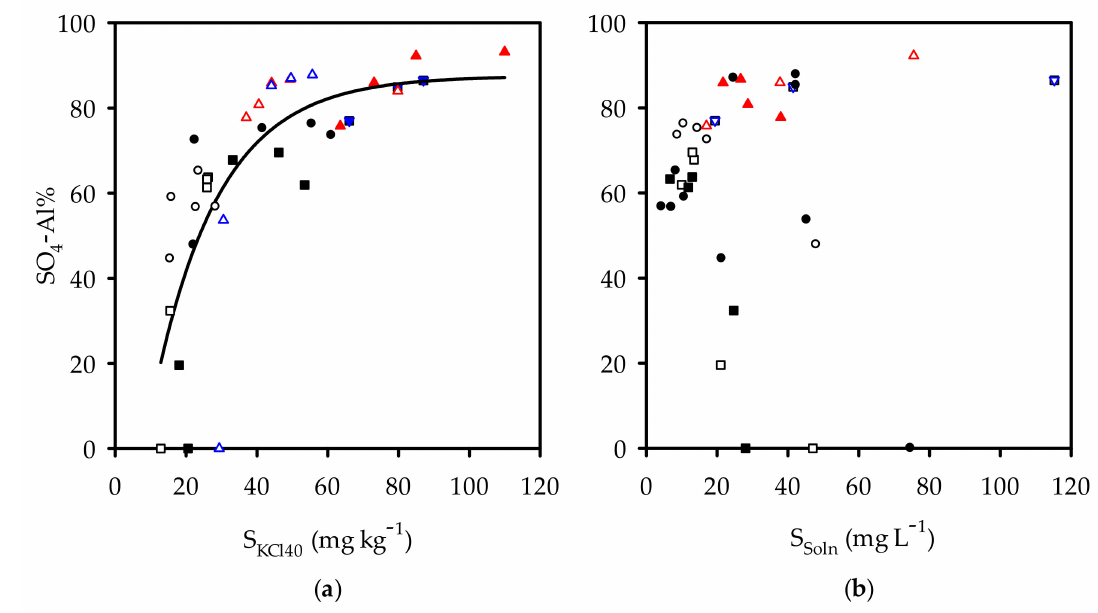
Figure 7. Relationship between SO 4 -Al% and ( a ) S KCl40 ( SO 4 − Al % = − 46.4 + 133.9 x ( 1 − exp ( − 0.05 x S KCl 40 ) , r 2 = 0.56) and ( b ) S Soln for the ST experiment treatments C ( ), L ( (cid:3) ), G ( (cid:52) ), and L + G ( (cid:53) ), and for the LT experiment treatments C (cid:35) ( • ), L ( (cid:4) ), G ( (cid:78) ), and L + G ( (cid:72) ).